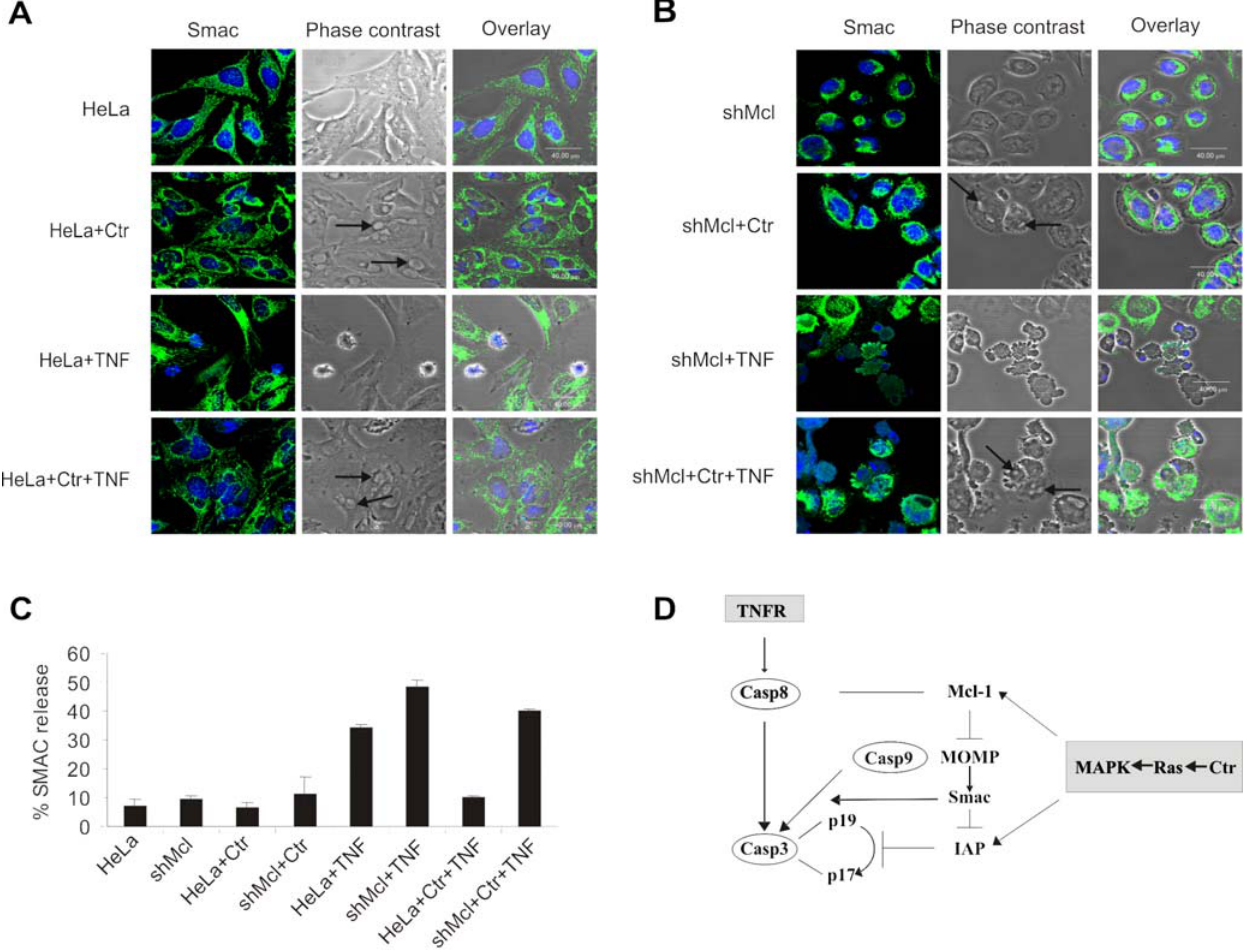
Figure 5. Mcl-1 is primarily required to resist mitochondrial outer membrane permeabilization and caspases activation in C. trachomatis infected cells. ( A,B ) Mcl-1 is required for preventing the release of Smac from the mitochondria of C. trachomatis infected cells upon TNF/CHX induction. Control (HeLa cells with empty vector) (A) and shMcl cells (B) were infected at an MOI of 5 and treated with TNF/CHX as mentioned in Experimental procedures. Shown are images from one representative experiment. Smac was stained in green and nuclei in blue. The arrows point to chlamydial inclusions (C) Quantification of cells with released Smac (for details see Experimental procedures). Shown are the data from three independent experiments. Error bars represent the 6 SD of the mean. (D) Model of signaling cascades involved in apoptosis inhibition during the early phase of Chlamydia infection. Infection induces the activation of MAPK pathways resulting in the upregulation and stabilization of Mcl-1 and IAP. Mcl-1 upregulation prevents the mitochondrial outer membrane permeabilization and the release of the IAP inhibitor Smac/DIABLO. IAPs prevent the activation of caspases, particularly the conversion of the caspases-3 inactive p19 fragment to the active p17 fragment.